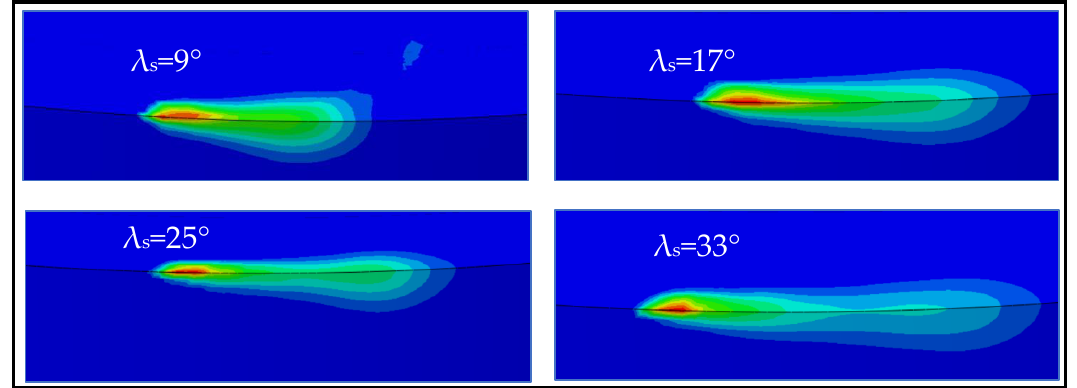
Figure 11. Temperature contours on the tool cutting edge at different inclination angles ( V = 100 m/min).